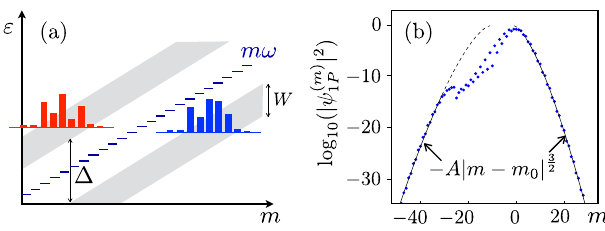
FIG. 6. Effective Zener tunneling problem for the Floquet states in harmonic space. (a) The Floquet problem, Eq. (A1), is equivalent to a tight-binding problem in harmonic ( m ) space, with a linear potential term m ω . The effective bands have a characteristic width W and gap Δ . The gray regions indicate the “ classically allowed ” regions for each fixed value of “ energy, ” as determined by the sum of the band energies and the linear potential. The Floquet wave functions in the two bands (illus- trated by the red and blue bars) are strongly localized in the classically allowed regions and decay rapidly beyond these regions. (b) Modulus squared of a representative Floquet wave function as a function of the Fourier index m . Sufficiently far from the maximum, the wave function decays as exp ð − A j m − m 0 j 3 = 2 Þ , where A and m 0 are